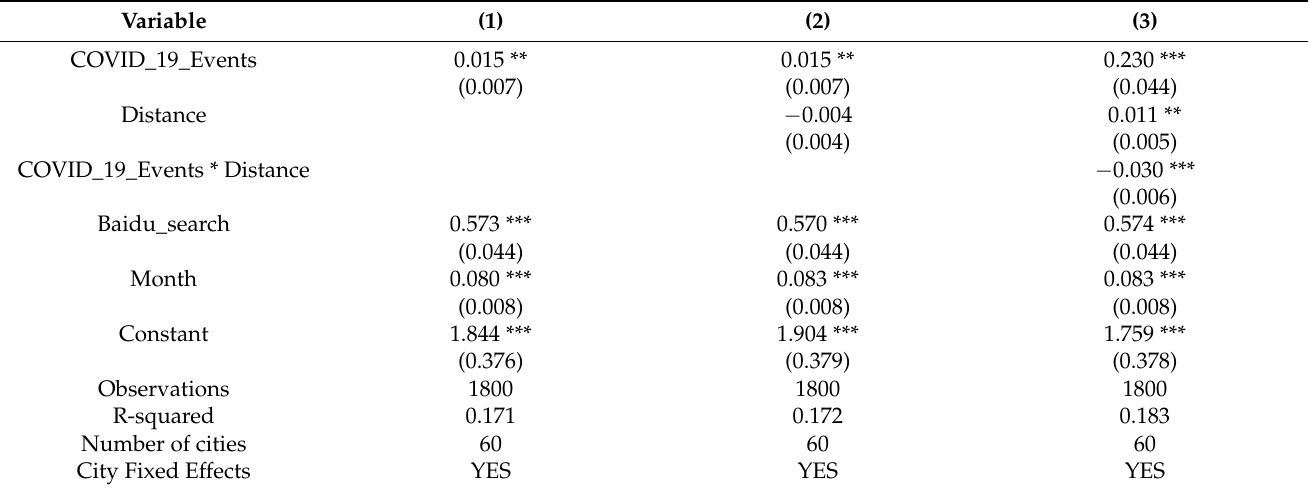
Table 3. Estimation results of the effects of discrete community transmission events of COVID-19 on health information